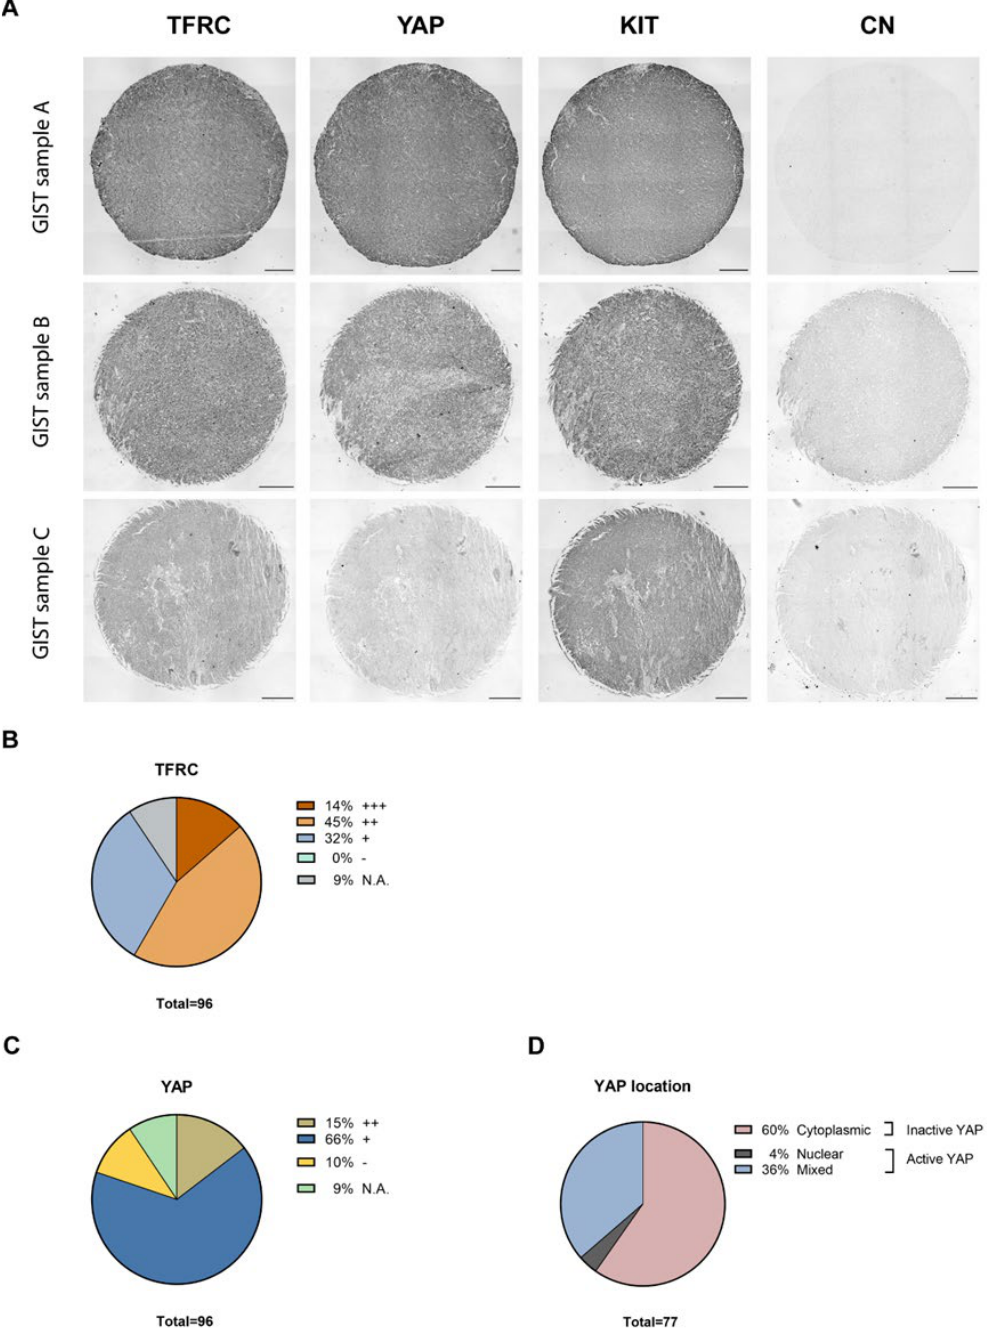
Figure 9. TFRC, YAP, and KIT immunohistochemistry on GIST tissue arrays. ( A ) Representative examples of TFRC, YAP, and KIT immunohistochemical staining in GIST TMA samples, graded as strong (+++), moderate (++), and weak (+) positive for TFRC-ir, and as strong positive (++) or positive (+) for YAP and KIT staining. Negative staining ( − ) was also observed for YAP-ir. Scale bars = 200 μm. ( B ) Proportions of GIST samples exhibiting different expression levels of the TFRC. ( C ) Proportions of GIST samples exhibiting different expression levels of YAP. ( D ) Proportions of GIST samples exhibiting active or inactive YAP. (N.A., Not Applicable).